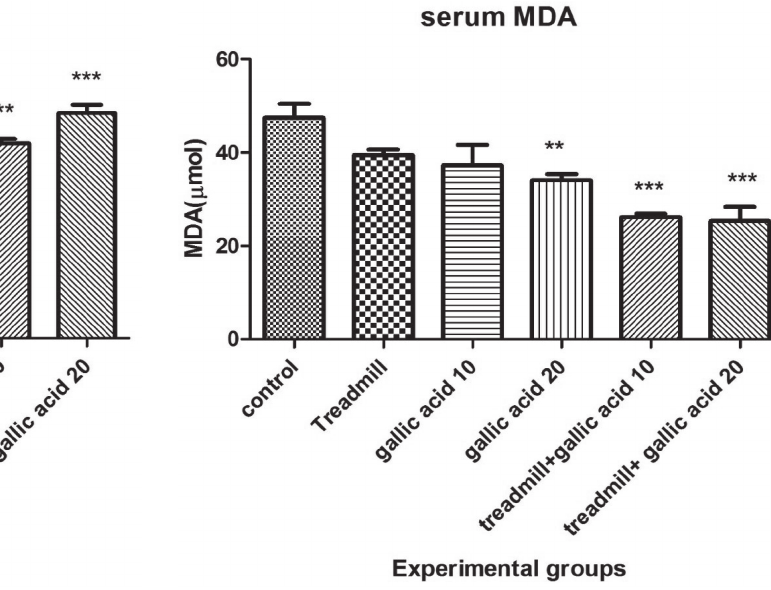
FIGURE 4 - The effects of gallic acid and physical exercise, alone and combined, on serum malondialdehyde level;